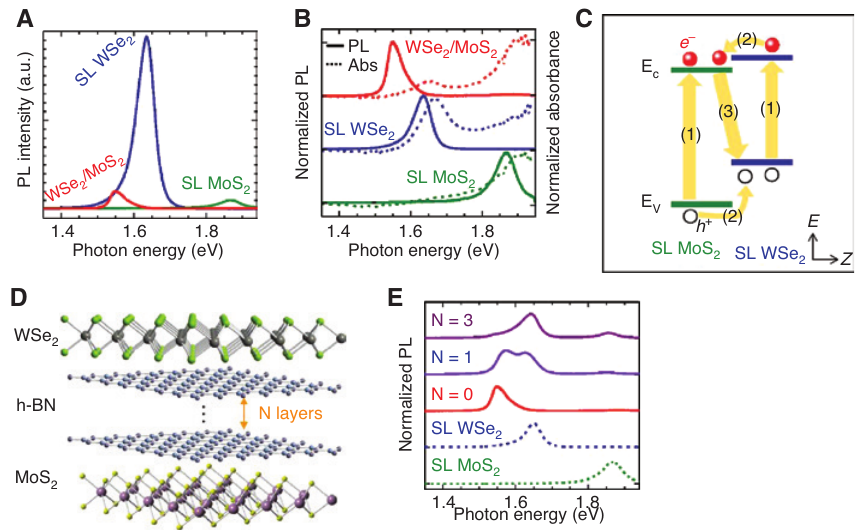
/MoS heterobilayers, taken from Ref. [58]. Figure 5: Photoluminescence and absorption from WSe 2 2 (A) PL spectra of single-layer WSe , MoS , and the corresponding heterobilayer. (B) Normalized PL (solid lines) and absorbance (dashed lines) 2 2 spectra of single-layer WSe , MoS , and the corresponding heterobilayer, where the spectra are normalized to the height of the strongest PL/ 2 2 absorbance peak. (C) Band diagram of WSe /MoS heterobilayer under photoexcitation, depicting (1) absorption and exciton generation in 2 2 WSe and MoS single layers, (2) relaxation of excitons at the MoS /WSe interface driven by the band offset, and (3) radiative recombination 2 2 2 2 of spatially indirect excitons. (D) An atomistic illustration of the heterostructure of SL WSe /SL MoS2 with few-layer h-BN spacer in the vdW 2 gap. (E) Normalized PL spectra from SL WSe /SL MoS2 heterostructure with n layers of hexagonal boron nitrite (n = 0, 1, and 2